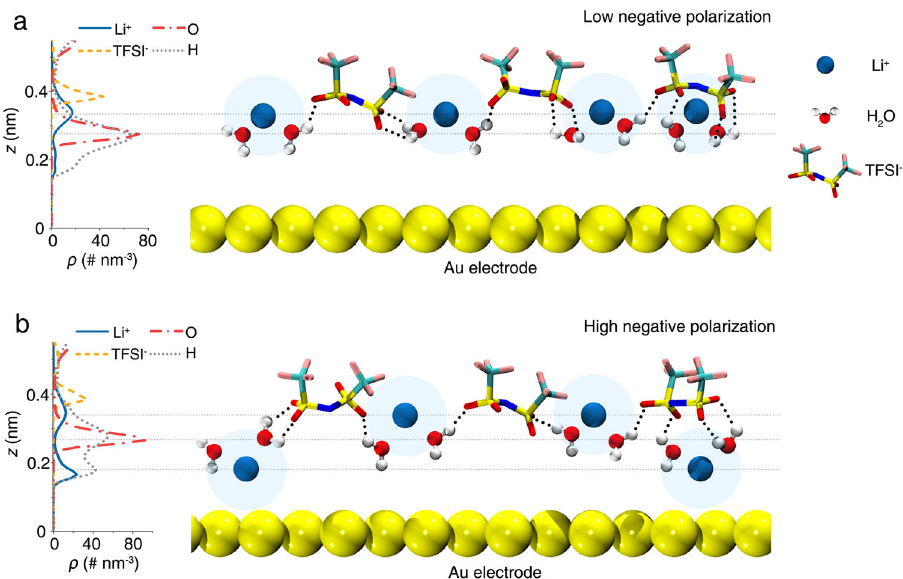
Fig. 4 | Schematic atomistic EDL structure in highly concentrated aqueous electrolyte. a , b Number densities pro fi les of various interfacial species (left), and thecorrespondingschematicEDLstructure(right)underlownegativepolarization, from 0 to ~ − 0.6V ( a ) and high negative polarization, from ~ − 1.5 to − 1.9V ( b ).